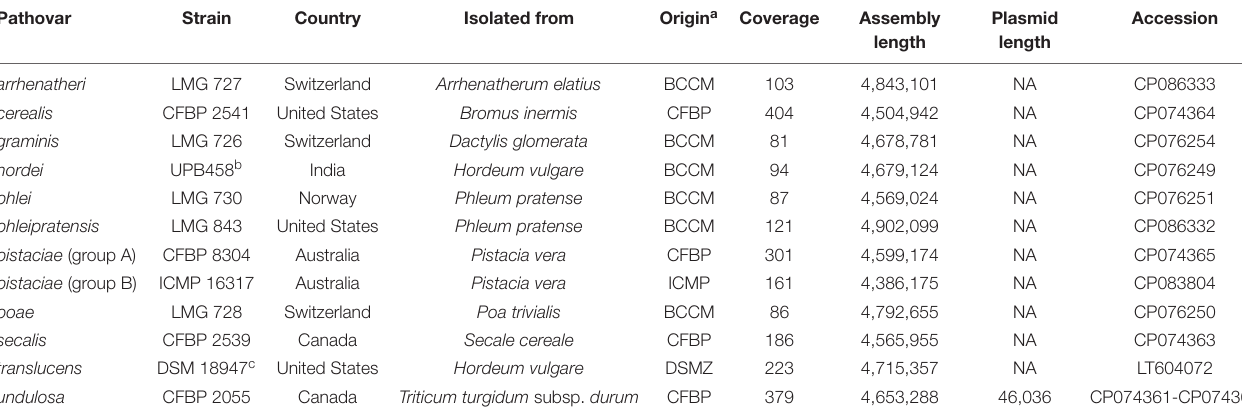
TABLE 1 | X. translucens pathotype strains used in this study and characteristics of the obtained genome assemblies.